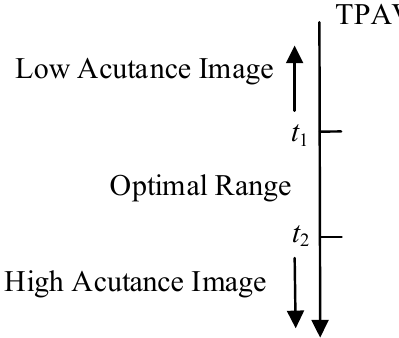
Figure 5. The optimal acutance range of the image on the TPAV axis.